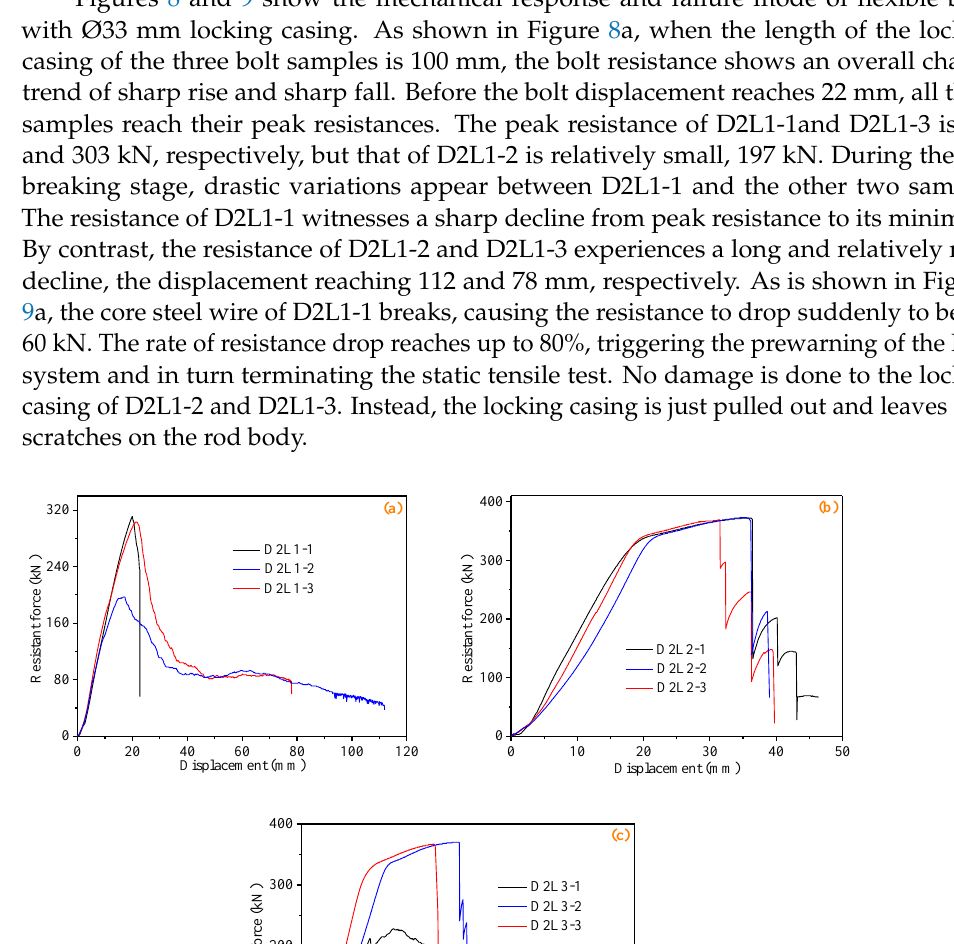
Figure 9. Failure mode of flexible bolts with Ø 33 mm locking casing: ( a ) D2L1, ( b ) D2L2, and ( c ) D2L3. 4.3. Flexible Bolts with Ø42 mm Locking Casing Figures 10 and 11 show the mechanical response and failure mode of flexible bolts with Ø 42 mm locking casing. As shown in Figure 10a, when the length of the locking casing of the three bolt samples is 100 mm, the resistance change trend of the three samples are approximately the same: firstly, a sharp increase to the peak resistance, then a drastic decline, and finally a long constant resistance deformation. Before the bolt displacement reaches 20 mm, all the three samples reach their respective peak resistances: D3L1-1, 333 kN; D3L1-2, 328 kN; and D3L1-3, 339 kN. After the peak resistance, the locking casings of the three samples are all pulled out, causing a sharp decline in bolt